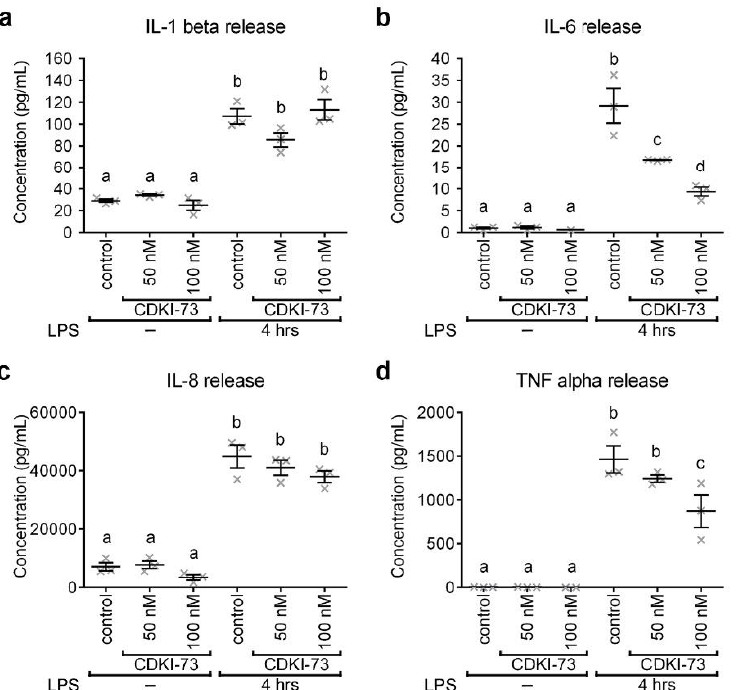
Figure 4. CDKI-73 reduces pro-inflammatory cytokine release by human THP-1 macrophages. ( a – d ) Comparative histograms showing the secretion of IL- 1β ( a ), IL-6 ( b ), IL-8 ( c ) and TNFα ( d ) from lipopolysaccharide (LPS)-stimulated THP-1 macrophages after the addition of CDKI-73 compound. One- way ANOVA and Tukey’s multiple comparison test showed significant differences between the means in designated groups (depicted by different letters on the bars, p < 0.0001). Data are represented as mean ± SEM.